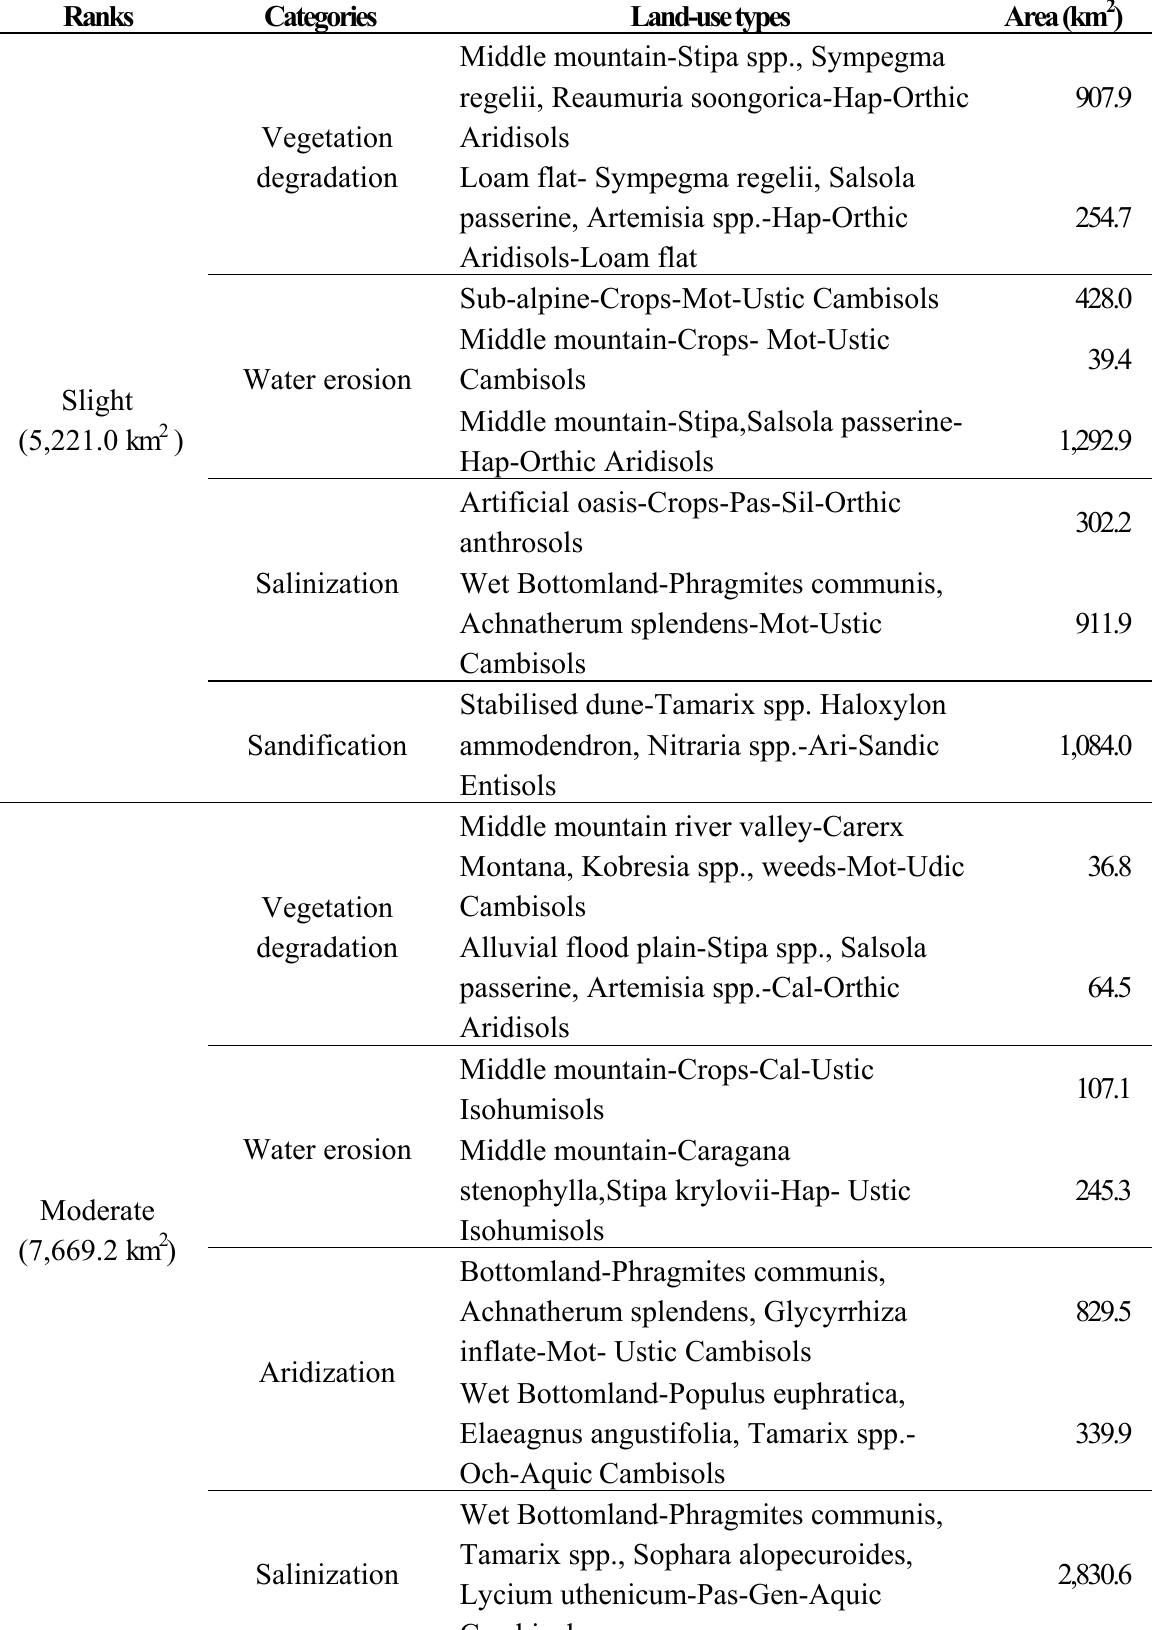
Table 4. Evaluation of degraded land in the Heihe River